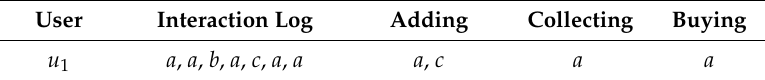
Table 3. A series of feedback for u 1 in a purchase cycle.